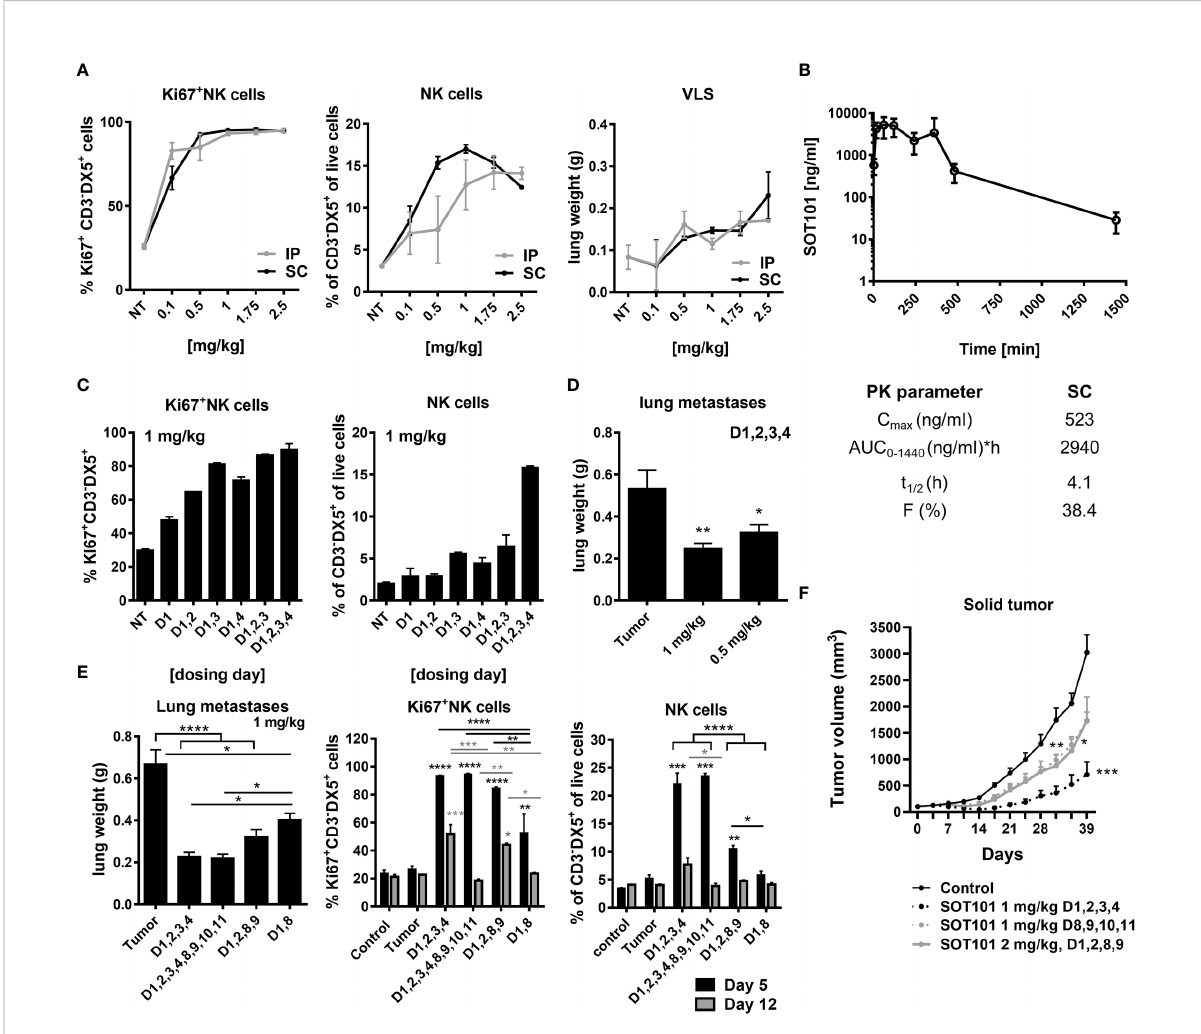
FIGURE 4 SOT101 activates NK cells and induces anti-tumor ef fi cacy in dependance on dose, administration route and schedule in vivo . (A) SOT101 was administered IP or SC once daily at the indicated doses into C57BL/6 mice at day 1,2,3,4 in 2 mice/group. NK cell proliferation and the relative expansion was analyzed from splenocytes by fl ow cytometry at day 5. Lung weight was determined at day 5 to detect vascular leakage syndrome (VLS). (B) SOT101 was administered SC at 2.5 mg/kg in 2 mice per time point. Serum was collected at 2 min, 15 min, 1 h, 2 h, 4 h, 6 h, 8 h, 24 h and 32 h after dose administration and analyzed by ELISA. Pharmacokinetic parameters were calculated. (C) SOT101 was administered SC at 1 mg/kg once daily at the indicated day. NK cell proliferation and the relative expansion was determined by fl ow cytometry at day 5. (D) SOT101 was administered SC at 0.5 or 1 mg/kg at day 1,2,3,4 in the Renca mouse tumor model. Lung metastases were evaluated as the lung weight at day 16. (E) Dosing schedule dependency of SOT101 at 1 mg/kg SC in Renca mouse model for prevention of lung metastases. NK cell activity from spleen was evaluated at day 5 and 12. (F) Dose and schedule dependency of SOT101 administered SC in solid multiple myeloma xenograft tumor model. Data represent mean ± SEM from 2-4 mice/group for PD and PK, and 8 mice/group for the anti-tumor ef fi cacy experiments in vivo . The results were considered statistically signi fi cant if * p < 0.05, ** p < 0.01, *** p < 0.001 or **** p <